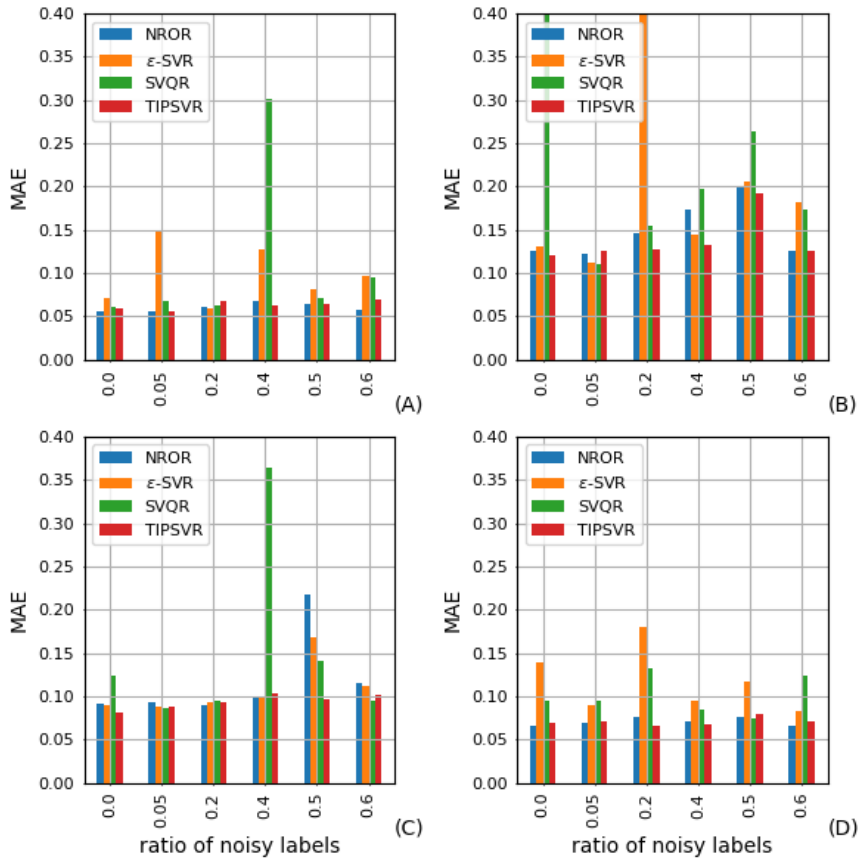
Figure 5. MAE for Gaussian noise of homogeneity on ( A ) CCPP, ( B ) DB, ( C ) EGSSD, ( D )